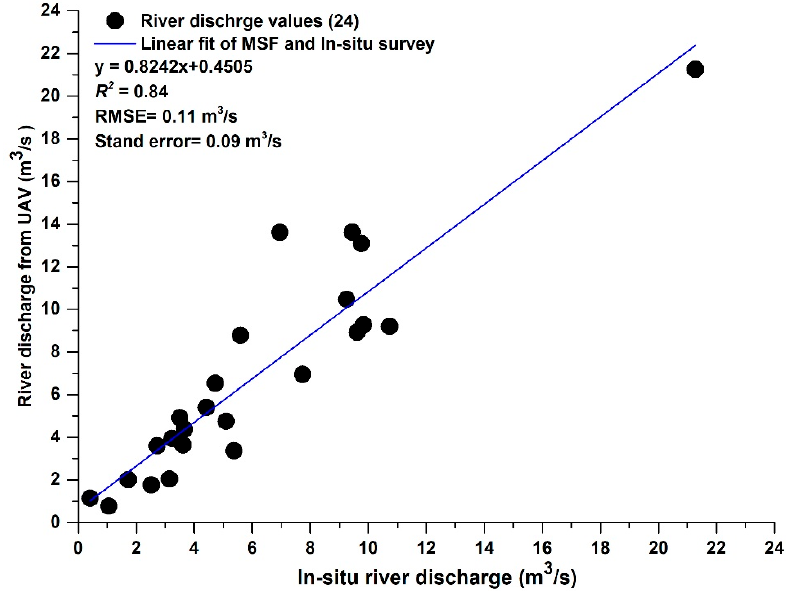
Figure 6. Validation of the calculated river discharge from the UAV.